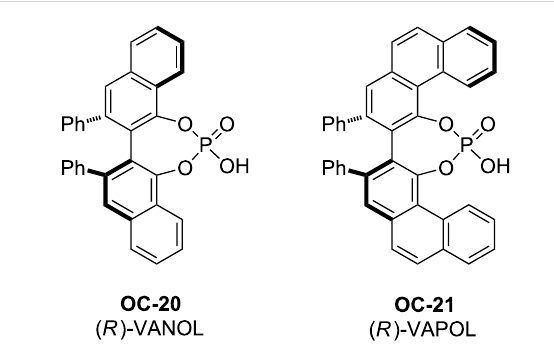
Figure 4: The chiral phosphoric acids catalysts OC-20 and OC-21 .